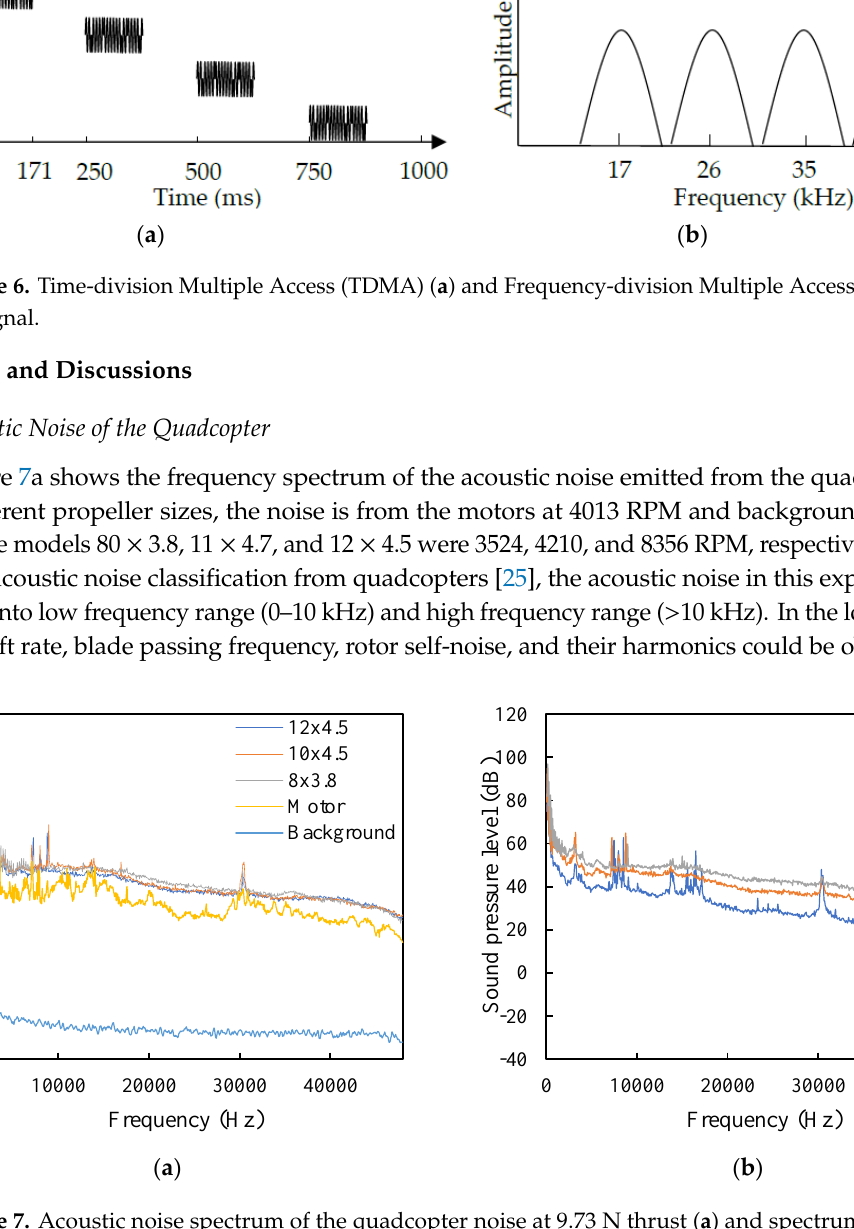
Figure 8. The effect of carrier wave changes to the noise tolerance. The longer M-sequence lengths and shorter chip rates trialed had larger SNR corr values (Figure 9). By doubling the length of the M-sequence, the SNR corr value increased by about 20. The M- sequence is multiplied by the sine wave (Equation (1)), so the correlation value increases as the M- sequence length increases. As the chip rate increased, the noise tolerance decreased. A chip rate of 24 kcps had the largest decrease in noise tolerance, because the 24 kHz carrier wave and 24 kcps chip rate compose the SSSound signal with 48 kHz broadband frequency that covered the quadcopter noise in the low frequency.